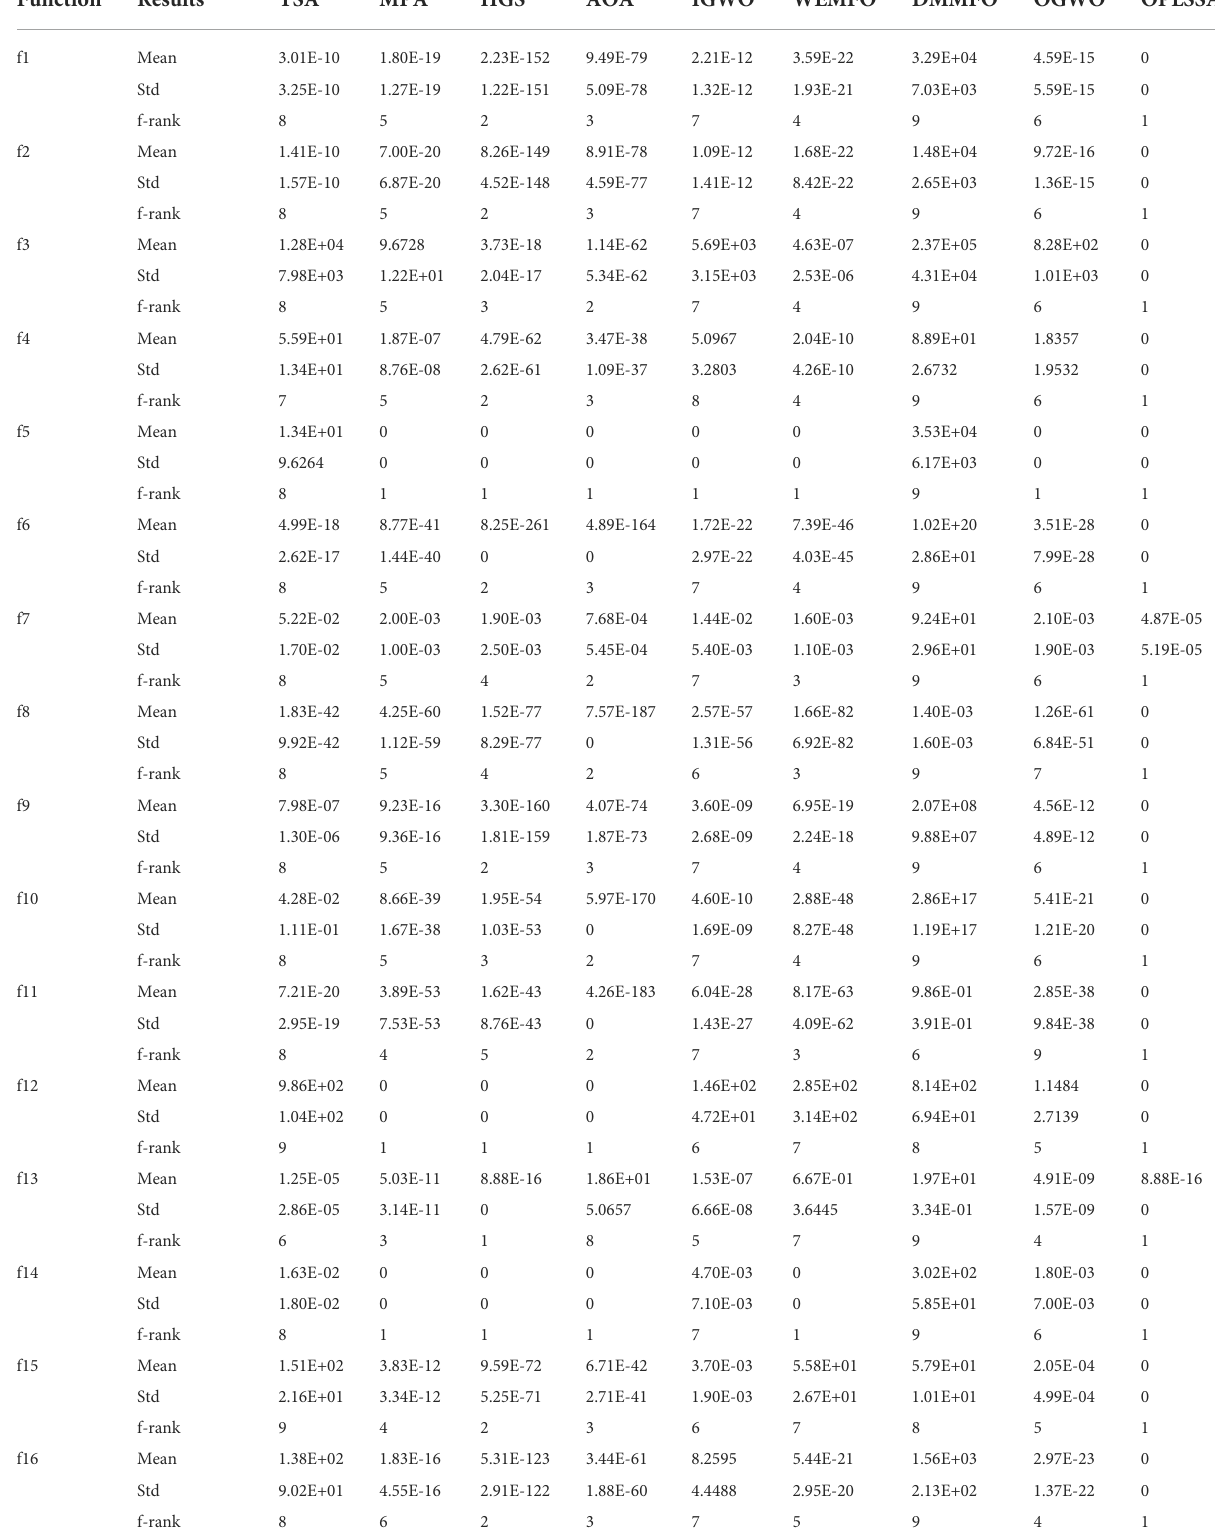
TABLE 5 Comparisons of nine algorithms on 23 test functions with 100 dimensions.